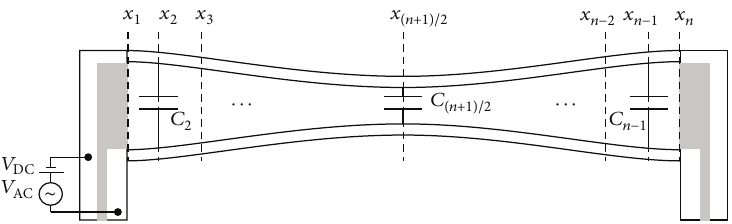
Figure 4: The equivalent parallel capacitances model of the capacitive microswitch.